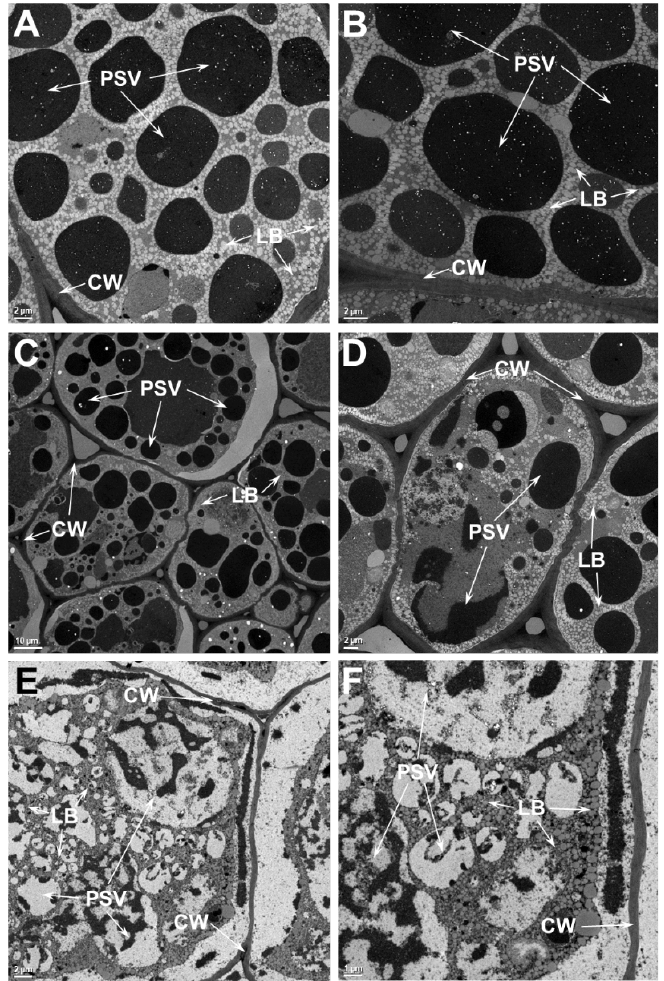
Figure 4. Transmission electron micrographs of heat stress sensitive (SG) soybean cotyledon grown at di ff erent temperatures. Low and high magnification micrographs of soybean cotyledons that were grown at 28 / 22 ◦ C ( A , B ) or 36 / 24 ◦ C ( C , D ) and 42 / 26 ◦ C ( E , F ) day / night temperatures. Numerous protein storage vacuoles and lipid bodies are observed in these cells. Note the distortion of protein storage vacuoles are apparent even at 36 / 24 ◦ C ( C , D ) and the complete loss of structural integrity in the cotyledonary cells of sensitive soybean genotype grown at 42 / 26 ◦ C ( E , F ). PSV, protein storage vacuoles; LB, lipid bodies; CW, cell wall.